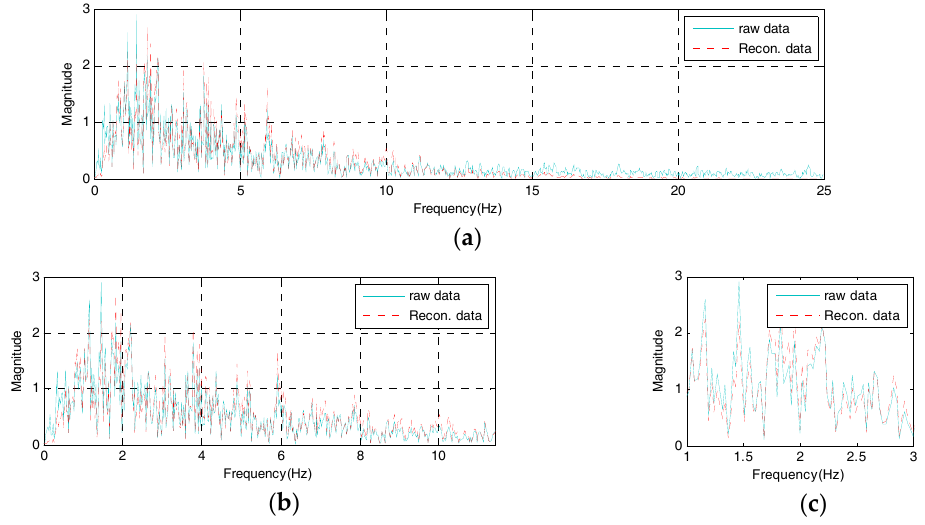
Figure 14. Frequency domain of the reconstructed signal from the IDAQ system: ( a ) frequency from 0 to 25 Hz ; ( b ) Detail 1; ( c ) Detail 2.